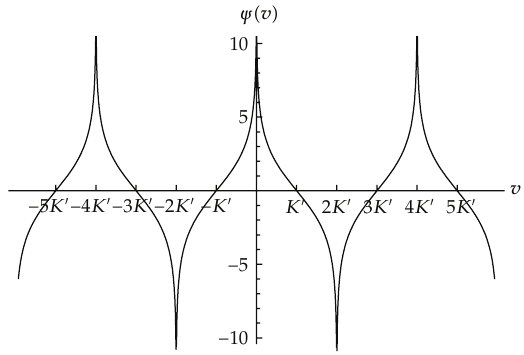
Figure 4: The solution ψ (cid:3) v (cid:4) (cid:8) ln (cid:3)(cid:3) dn (cid:3) v,k (cid:2) (cid:4) (cid:7) cn (cid:3) v,k (cid:2) (cid:4)(cid:4) / (cid:3) dn (cid:3) v,k (cid:2) (cid:4) − cn (cid:3) v,k (cid:2) (cid:4)(cid:4)(cid:4) for the Poisson Boltzmann equation. The parameters are k 2 (cid:8) 0 . 75 and K (cid:2) (cid:8) 1 .